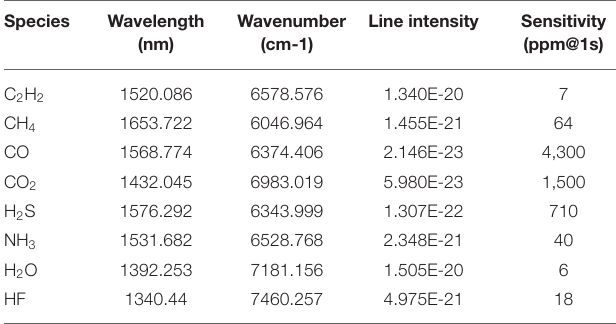
TABLE 2 | Detectable molecule in the near infrared spectral range and the estimated sensitivity. Species Wavelength Wavenumber Line (nm) (cm-1)